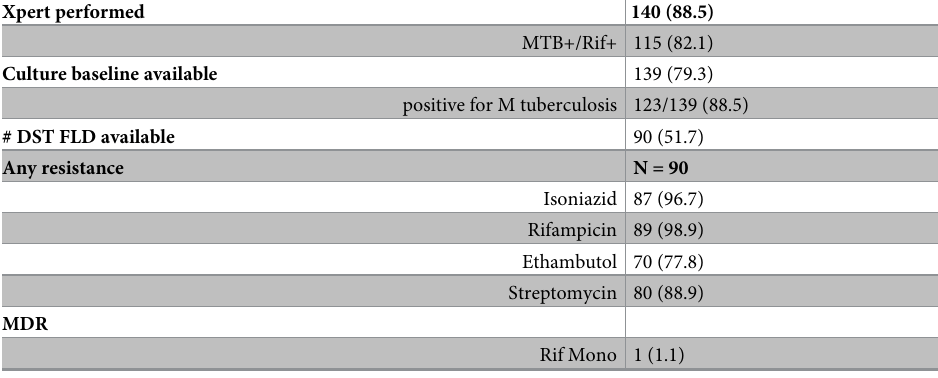
Table 2. Baseline bacteriological results N =